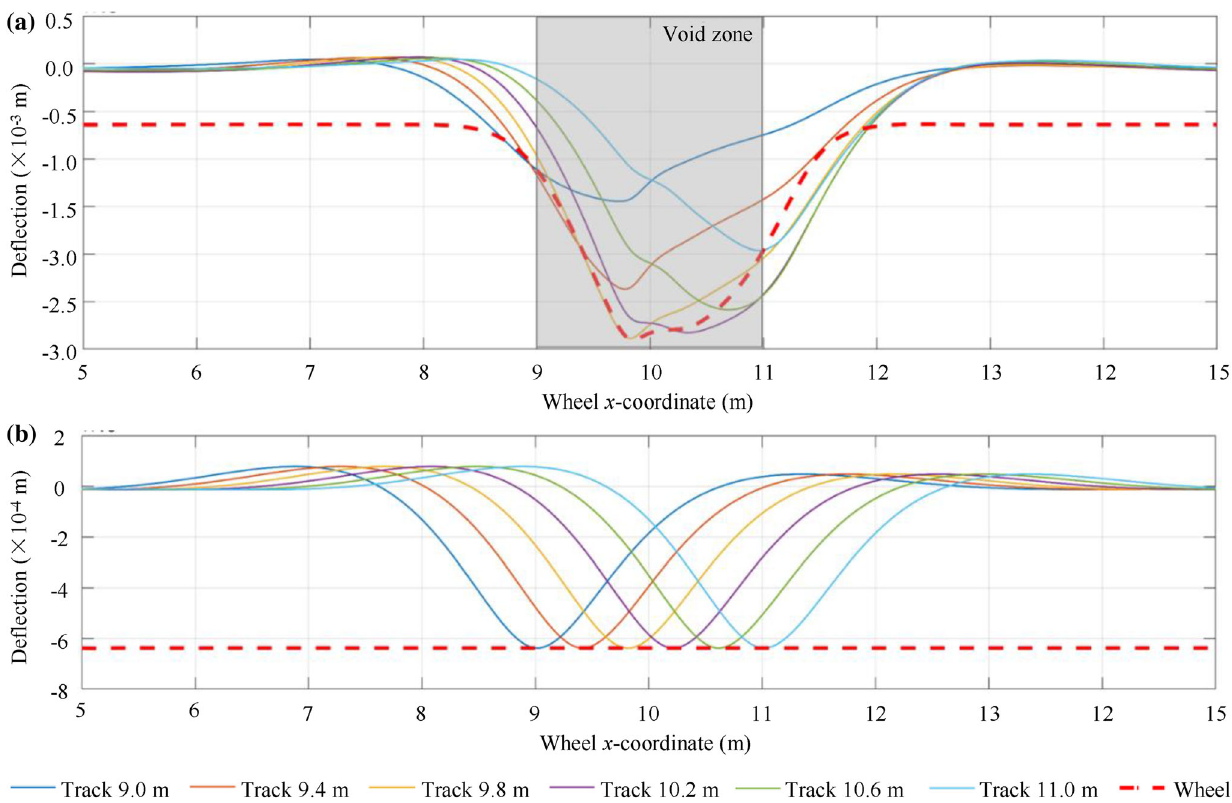
Fig. 9 Simulated rail deflections and wheel trajectory in the voided zone ( a ) and the zone without voids ( b